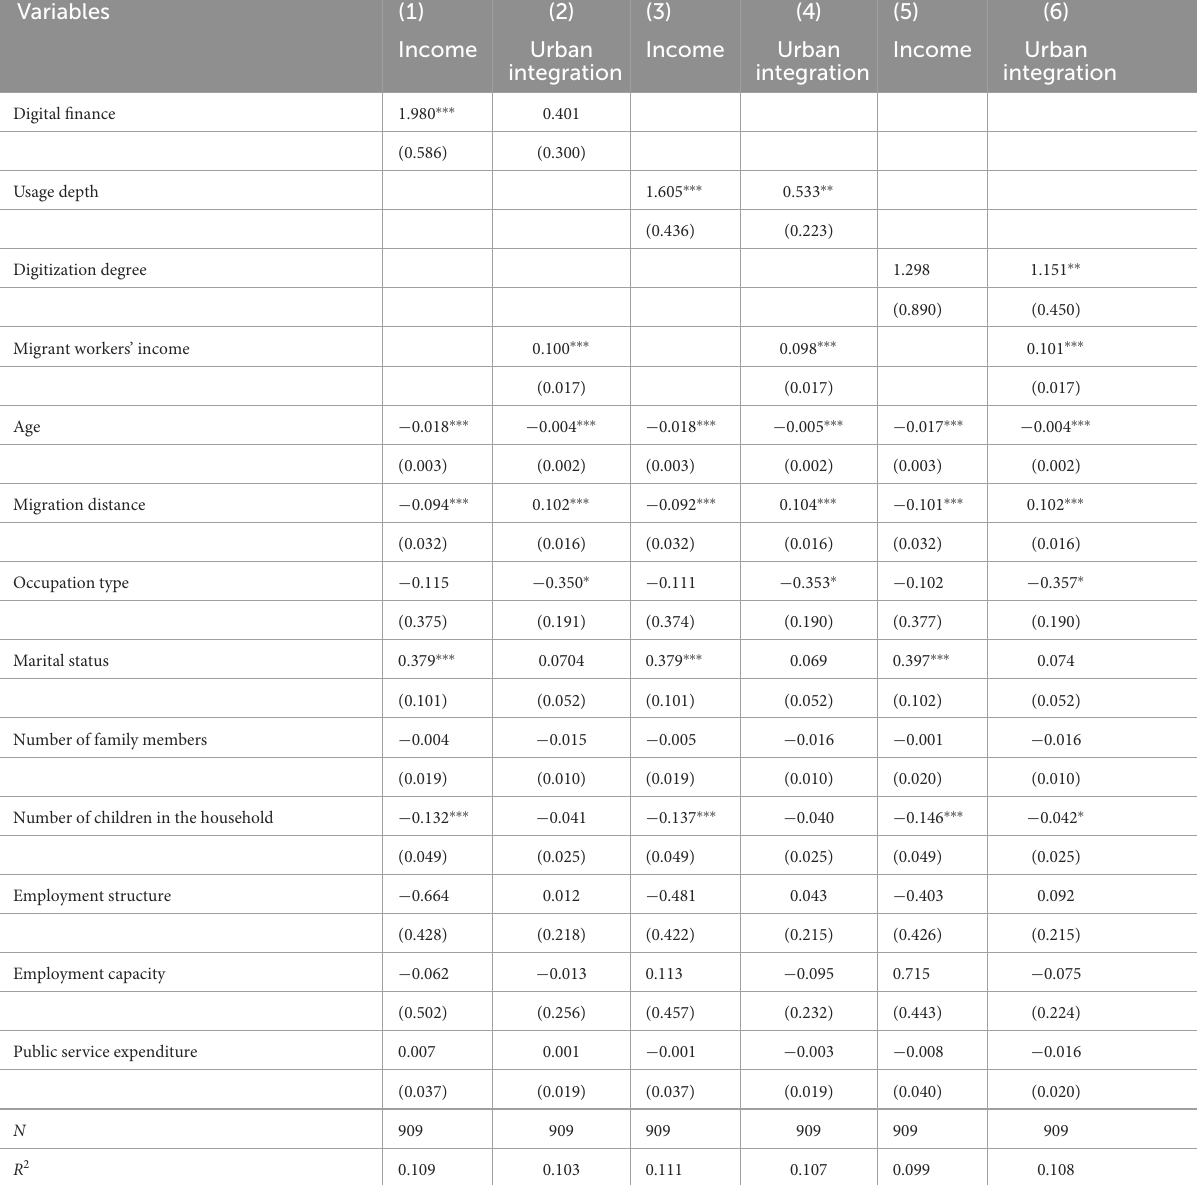
TABLE 7 Results of the effect of digital finance on migrant workers’ urban integration (mediation effect of their income).